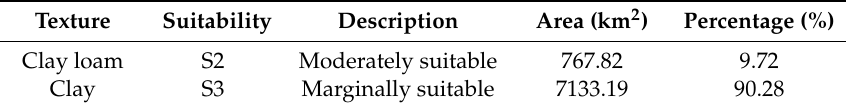
Table 4. Suitability classes based on soil texture.